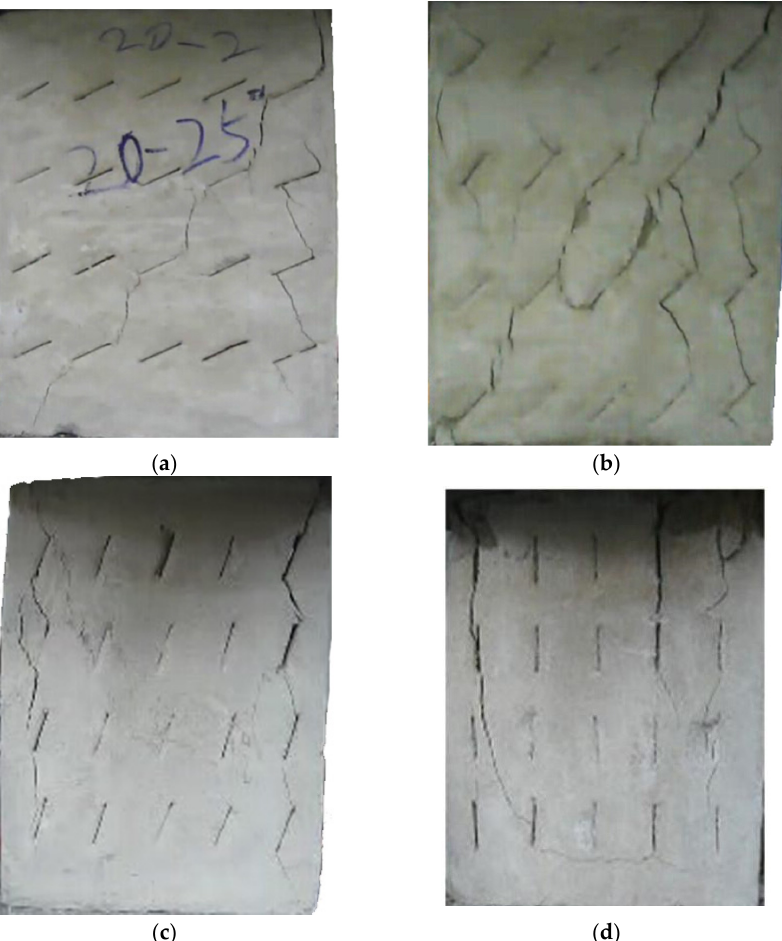
Figure 9. The failure process with 20 cracks. ( a ) 25°; ( b ) 45°; ( c ) 75°; ( d ) 90°.